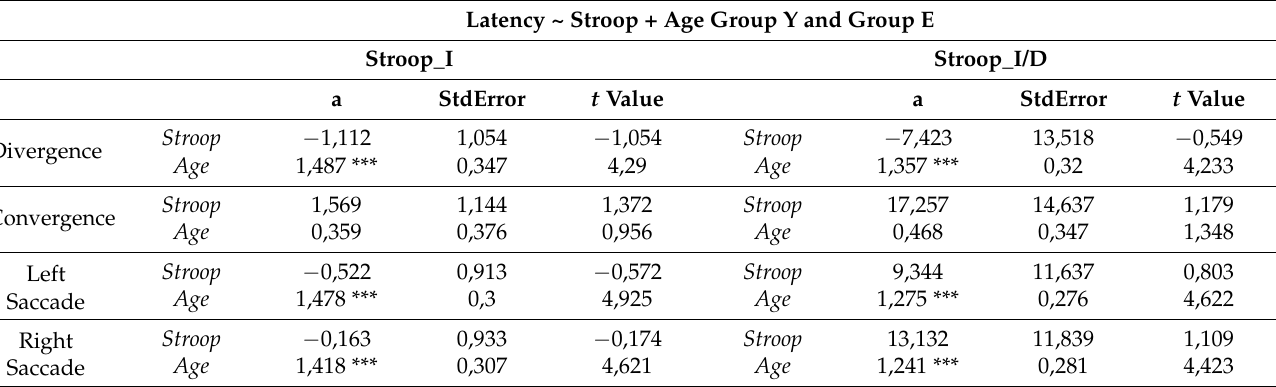
Table 4. Multiple regressions: eye movement latency as a function of Stroop scores and